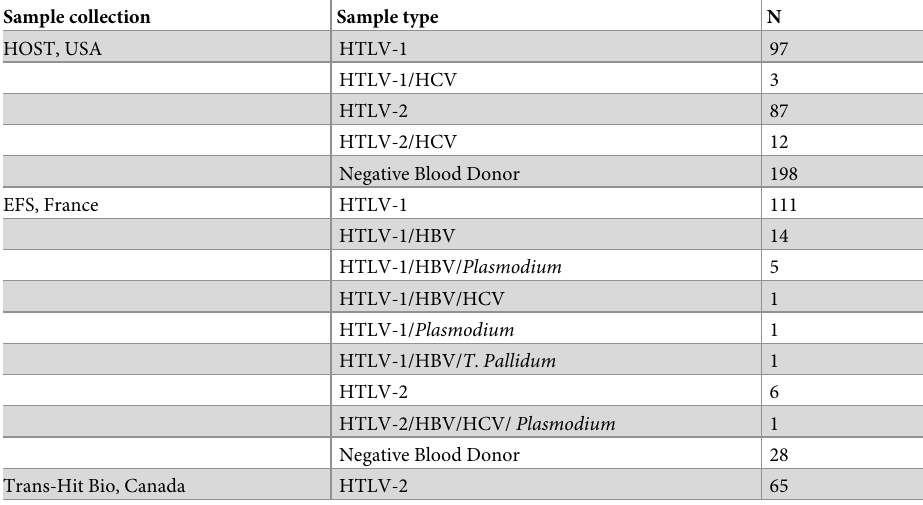
Table 1. Summary of sample collections